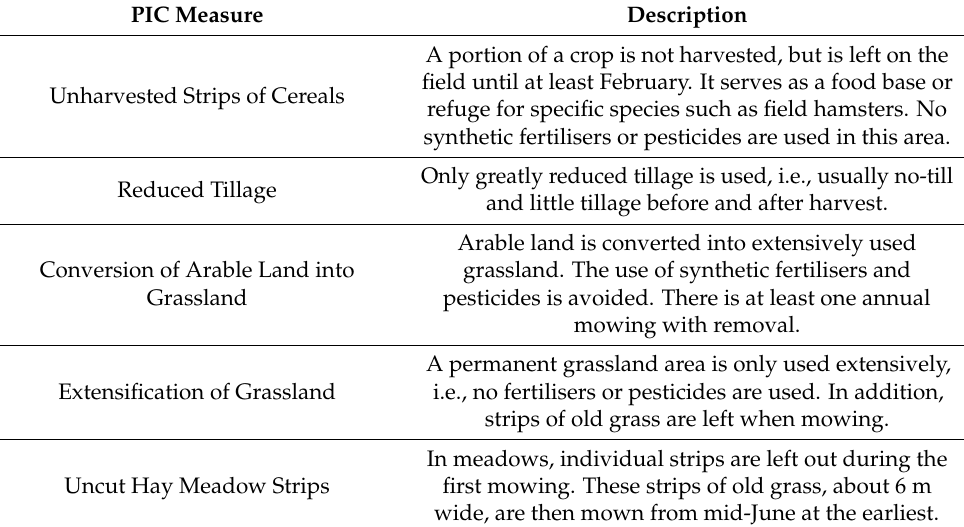
Table 1. Cont. PIC Measure Description